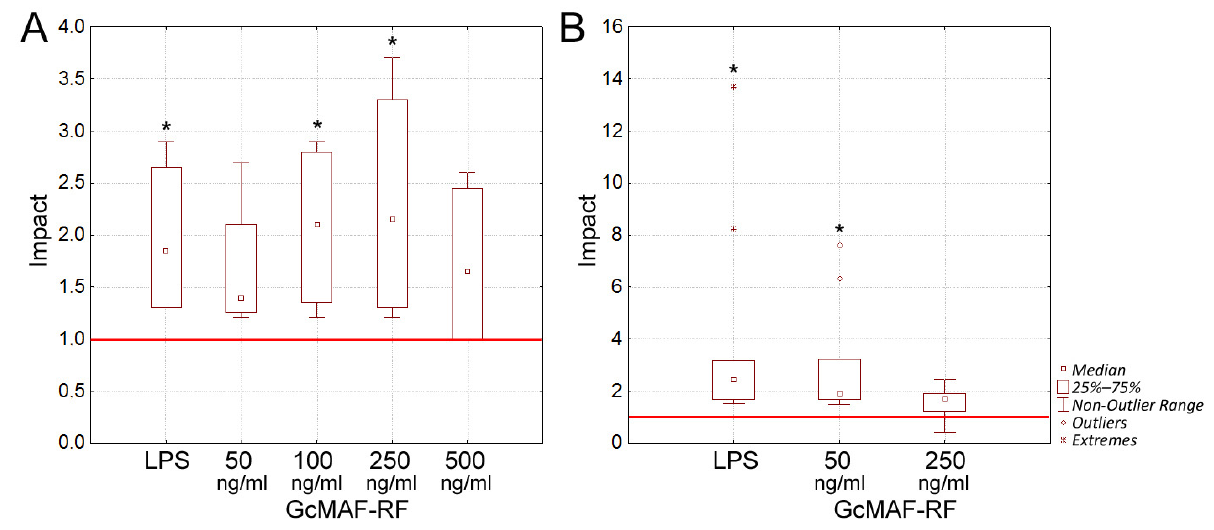
Figure 2. Ex vivo analysis of the effect of GcMAF-RF on immunocompetent cells. ( A ) Allostimulatory activity of human DCs activated by either the standard activator LPS or various concentrations of GcMAF-RF. The allostimulatory activity of DCs in the absence of activators was taken to be unity (red line). * significant differences from DCs without activators, p < 0.05 (Mann–Whitney U test). ( B ) The effect of GcMAF-RF on M1 polarization of human macrophages. Polarization was assessed based on allostimulatory activity of M1 polarized macrophages. LPS and GcMAF (50 and 250 ng/mL) were used as maturation inducers. Allostimulatory activity of intact macrophages was taken to be unity (red line). * significant differences from unstimulated macrophages, p < 0.01 (Mann–Whitney U test). Impact—the ratio between stimulated DCs or macrophages and intact ones. The results indicate that the allostimulatory activity of DCs increased in response to